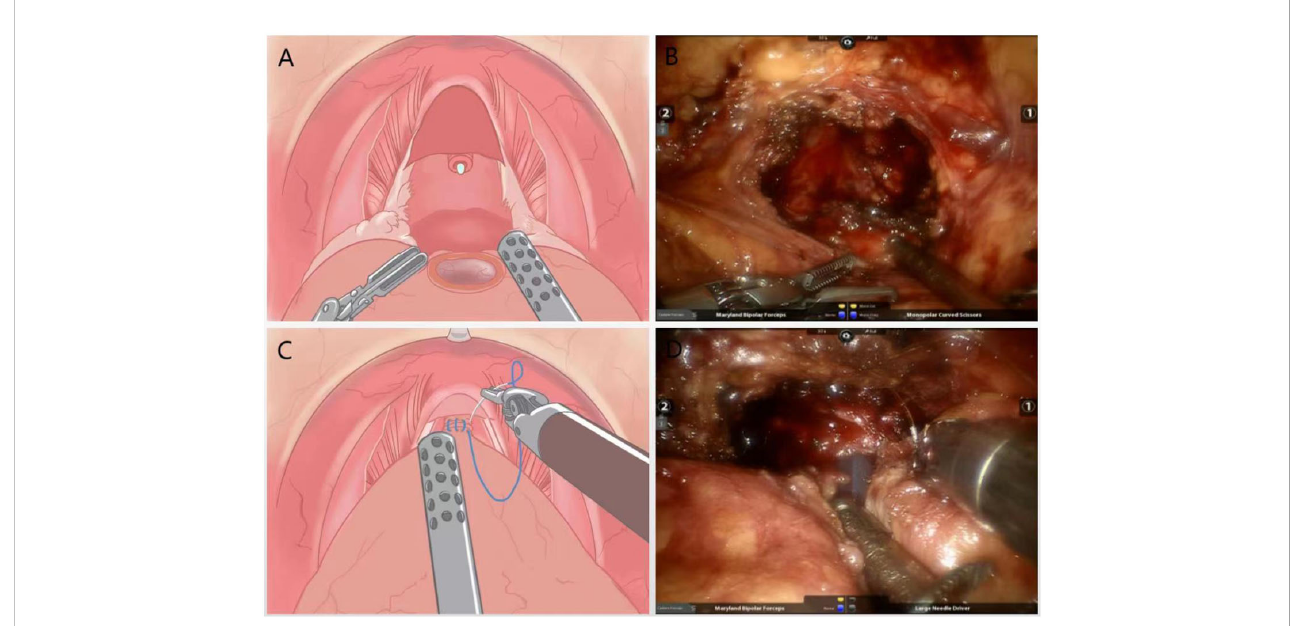
FIGURE 3 (A) Schematic diagram of the surgery to remove the prostate and preserve the “ hood ” structure around the gland; (B) Practical diagram; (C) Schematic diagram of anatomical reduction surgery with double stitches to close the urethra and bladder neck; (D) Practical